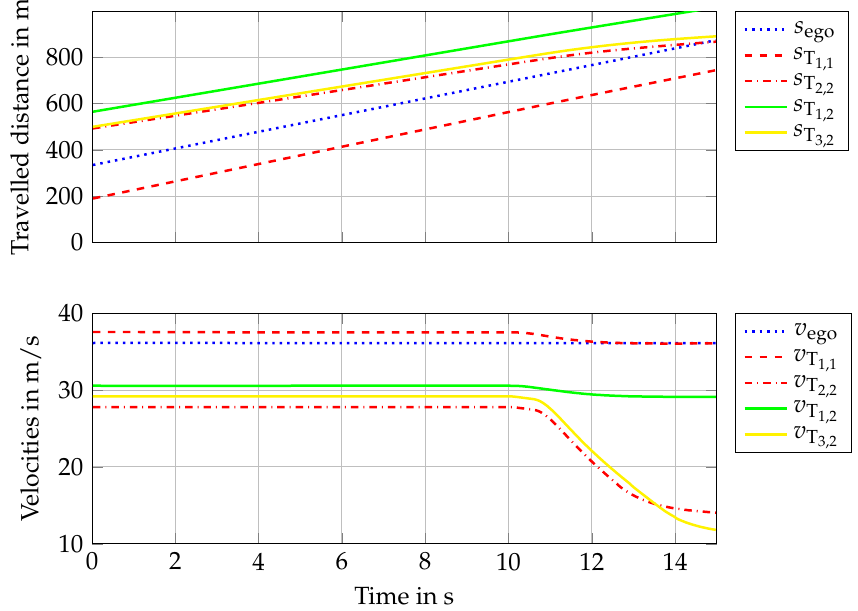
Figure 6. Distances traveled and velocities in the tested two scenarios. Velocity reductions are different for each lane which cause different criticality values, and this behavior is shown in Figure 7. It can be seen that the criticality of the ego lane has the longest criticality phase with a criticality value of 4 (high criticality). This is because of the aggressive speed-reduction maneuver of the front vehicle, T 2,2 . The right lane has a slightly lower criticality, and the left one has the lowest criticality over time. Because the left lane has a criticality of 2 (low criticality) until 7.72 s, it represents a potentially avoidable situation for the ego vehicle in this time interval. Therefore, the overall criticality c s for the ego vehicle is one level lower between 5.92 s and 7.62 s, as shown in Figure 7. This is only valid up to 7.62 s, where the ego vehicle comes closer to the vehicle T 2,2 and the potential evasive maneuver space becomes smaller. The last point where the ego vehicle could make evasive maneuver is at the point where the TTR time intersects the τ H at 11.6 s. After that, th a collision cannot be avoided